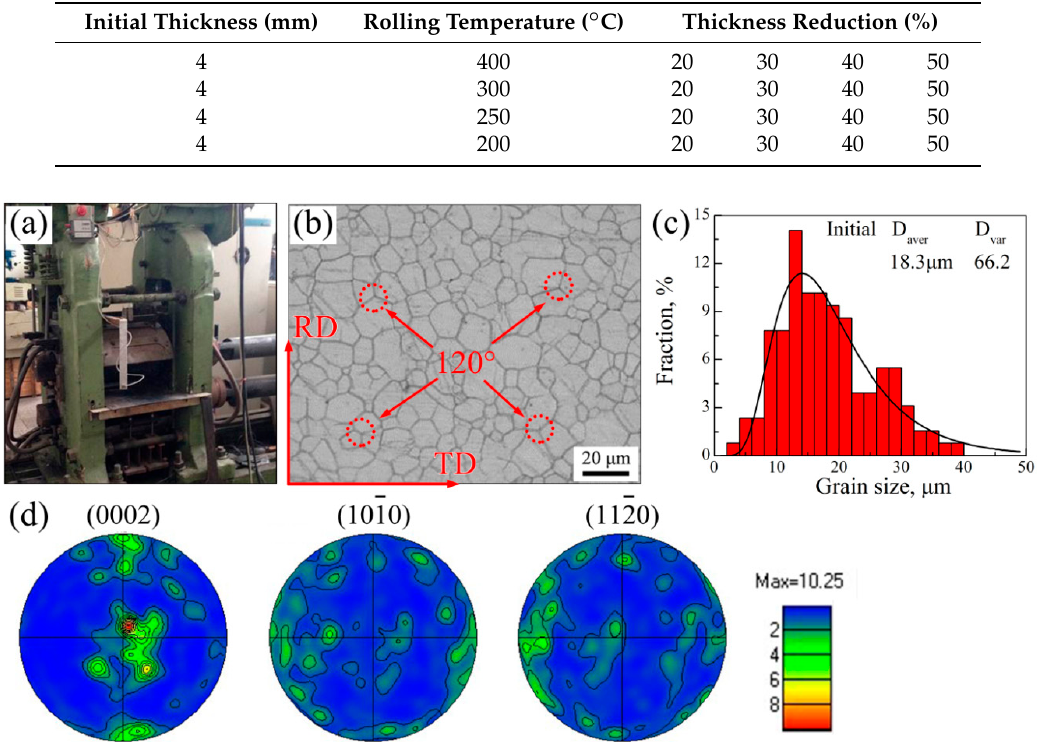
Figure 1. The equipment of the rolling mill ( a ), and microstructure characteristics regarding metallography observation ( b ), corresponding grain size distribution ( c ), and (0002), (10-10), (11-20) pole figures of initial material ( d ) (RD: rolling direction, TD: transverse direction).